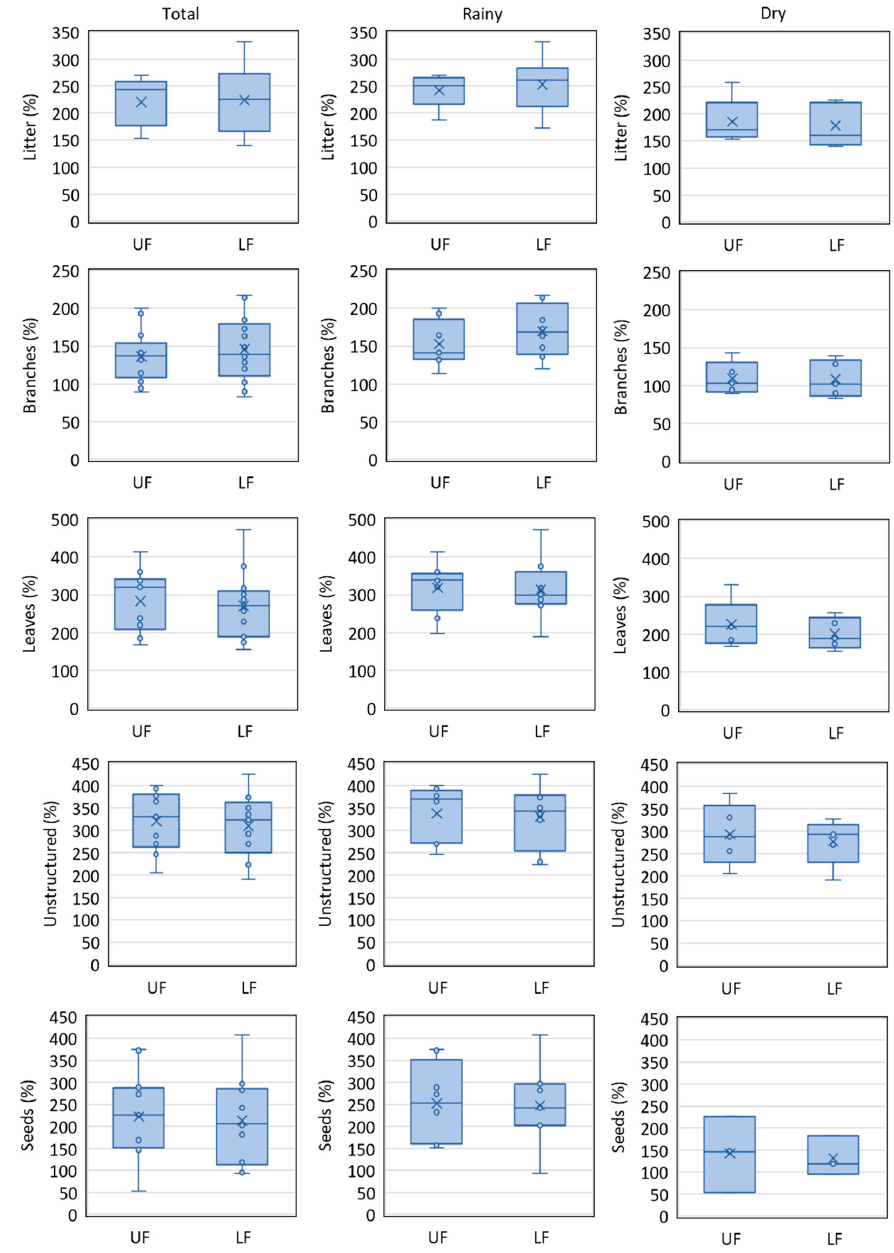
Figure 3. Monthly litter and fractions water-holding capacity for total period, rainy and dry seasons at unlogged (UF) and logged forest (LF), Jamari National Forest, Rondônia—Brazil. The mean effective water-holding [EWC, %] was similar for both stands ( p = 0.775) (UF = 48.7 ± 61.8% and LF = 49.3 ± 54.2%) (Figure 4). In general, both the annual and seasonal water content of litter did not differ significantly between stands but showed that litter contains more water during the rainy season. In the dry season, EWC was 41% and 35% lower than rainy for UF and LF, respectively. The W eff ranged from